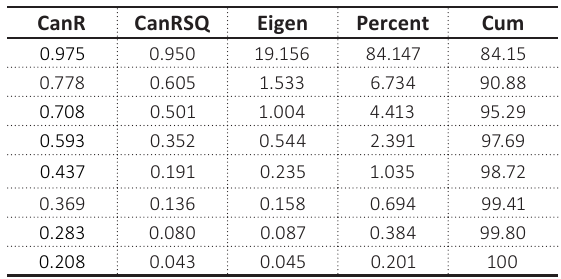
Table 3. Canonical square, eigen, percent and